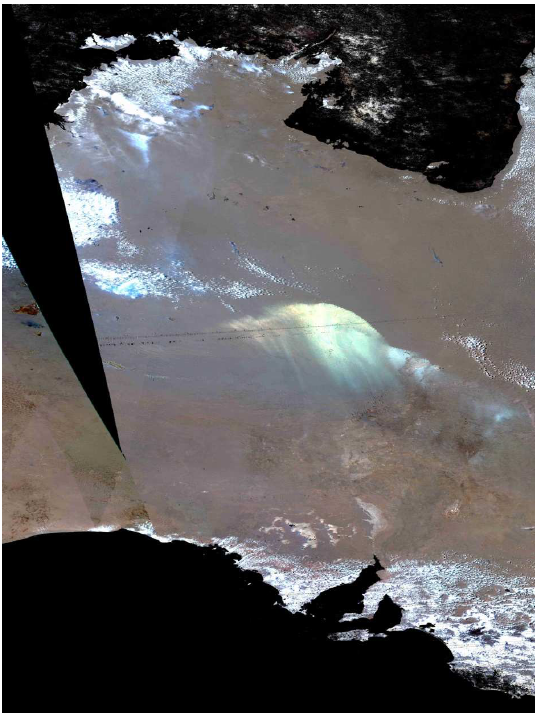
Figure 5. Dust storms detected from MODIS imagery using the reflectance change based